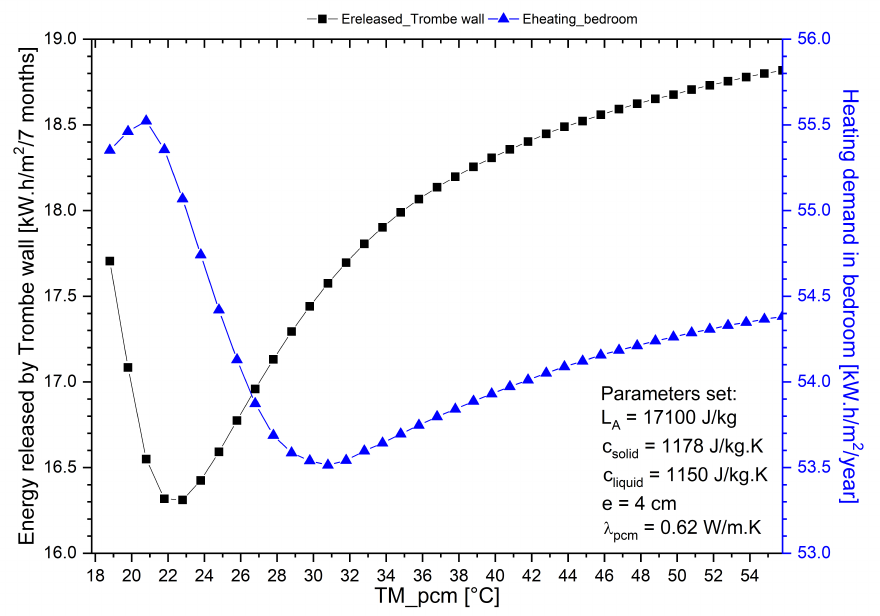
Figure 5. Energy released by the solar Trombe wall and heating demand in the bedroom vs. melting temperature during the cold season (7 months total: January–April and October–December).